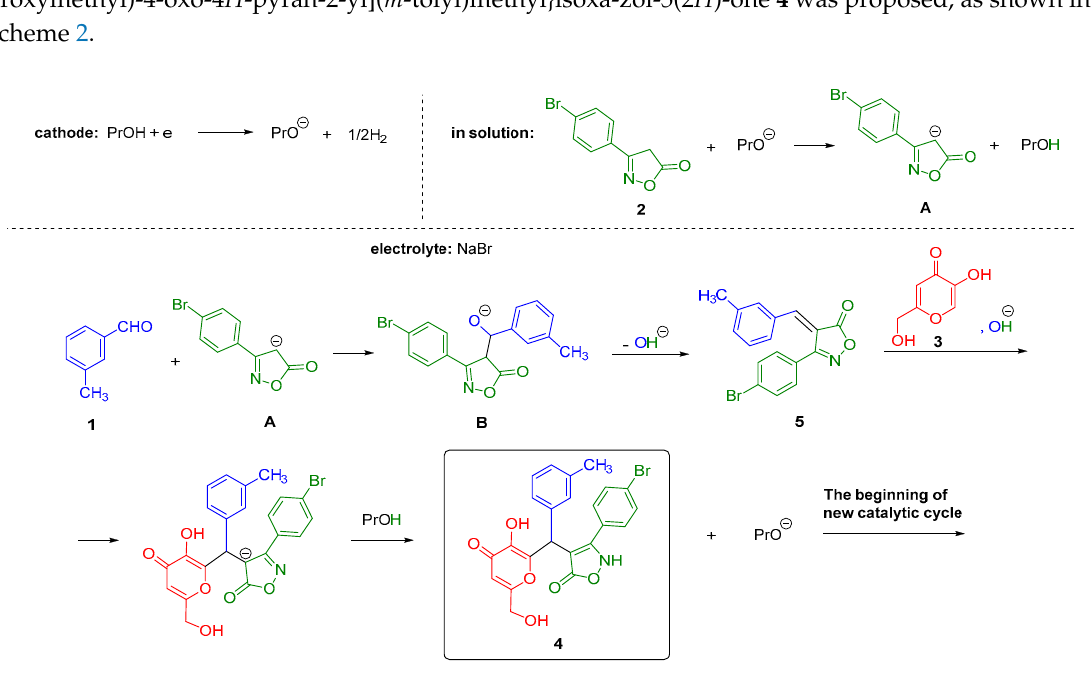
Scheme 2. Mechanism of electrocatalytic multicomponent transformation.